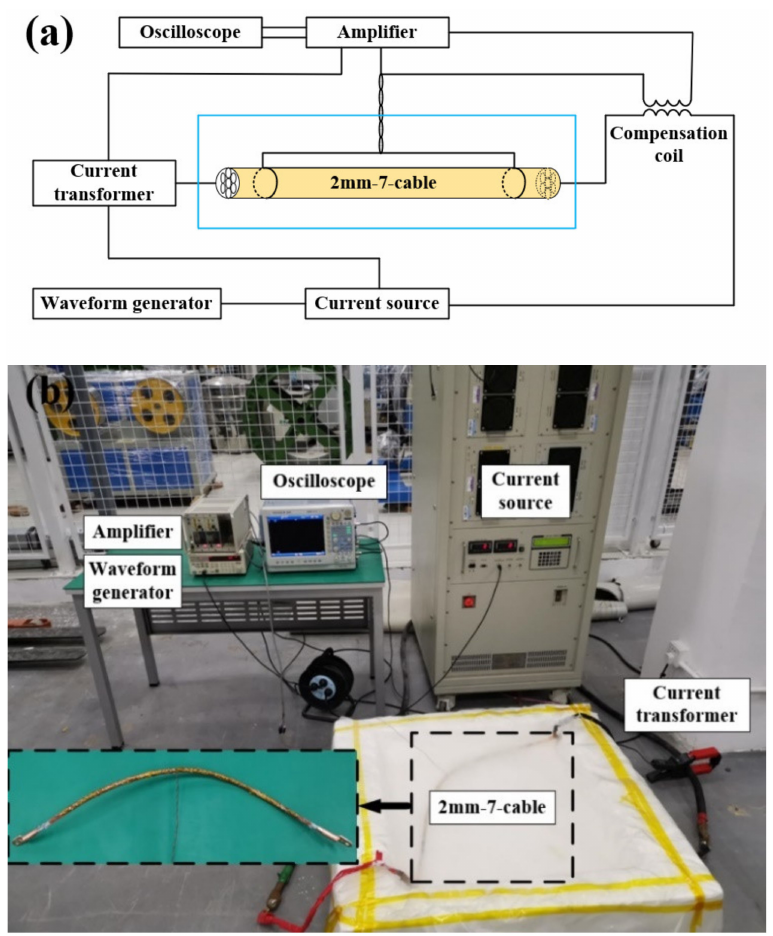
Figure 3. AC loss measurement system. ( a ) Schematic diagram; ( b ) Actual